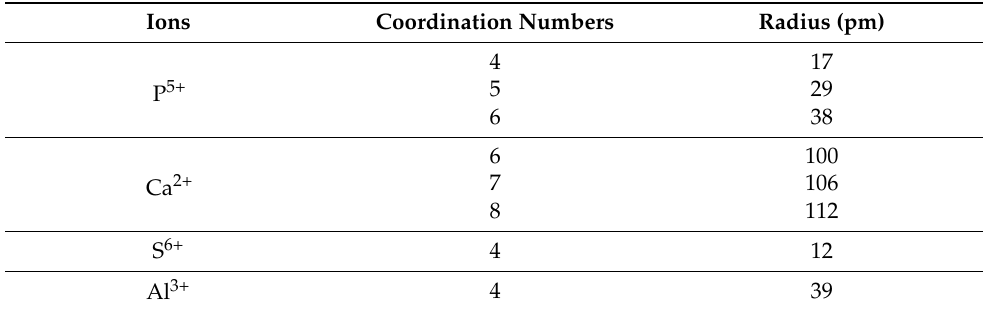
Table 4. Radii of ions involved in P-doped ye’elimite [55].